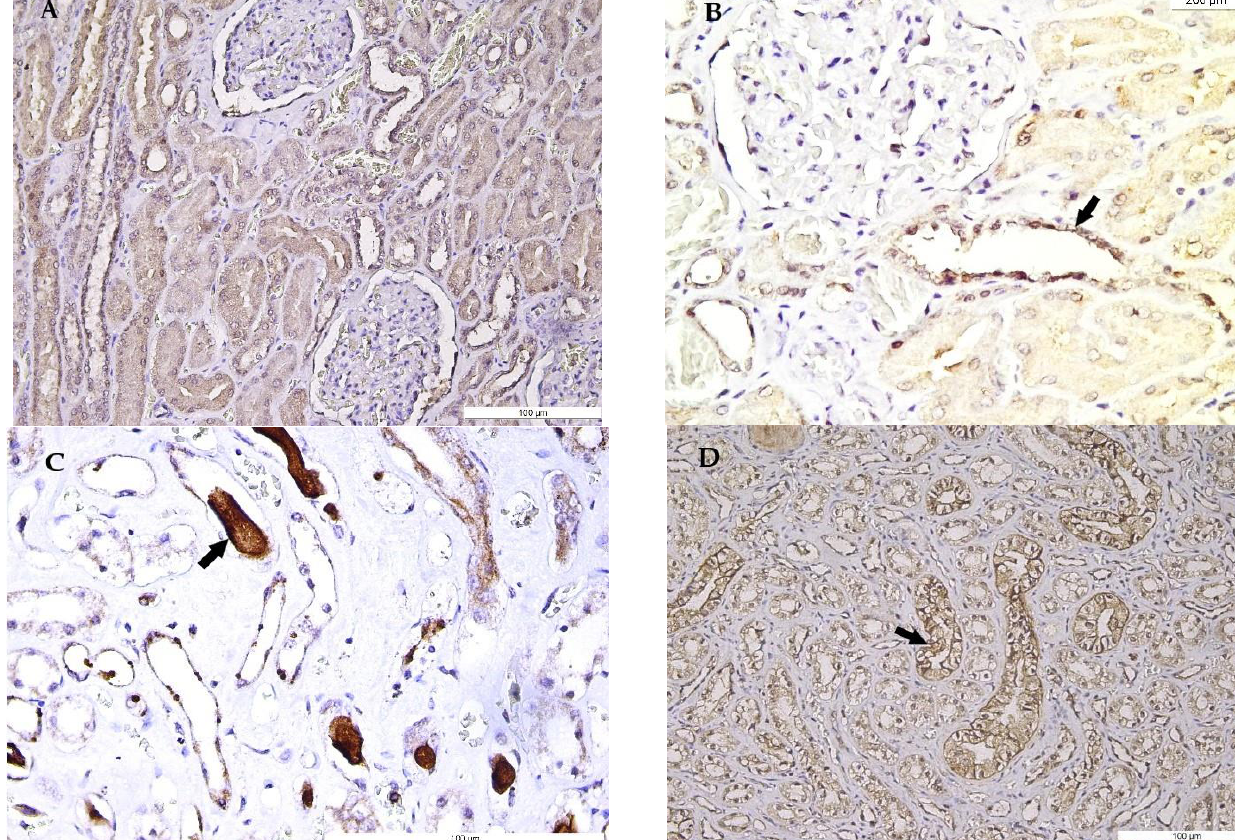
Figure 4. Ubiquitin (Ub) expression in the kidney in hypothermia cases. ( A ) General view of Ub expression in renal corpuscles and proximal and distal convoluted tubules. ( B ) Ub strong expression in renal corpuscle and distal convoluted tubules (arrow), compared with weak expression in proximal convoluted tubules. ( C ) Ub expression in distal convoluted and collecting tubules, Henle’s loops, and intratubular casts (arrow). ( D ) Cytoplasmic and focal membrane Ub expression in renal collecting tubules (arrow) and Henle’s loops epithelium and weak Ub expression in a tubular cast (left top of the image).